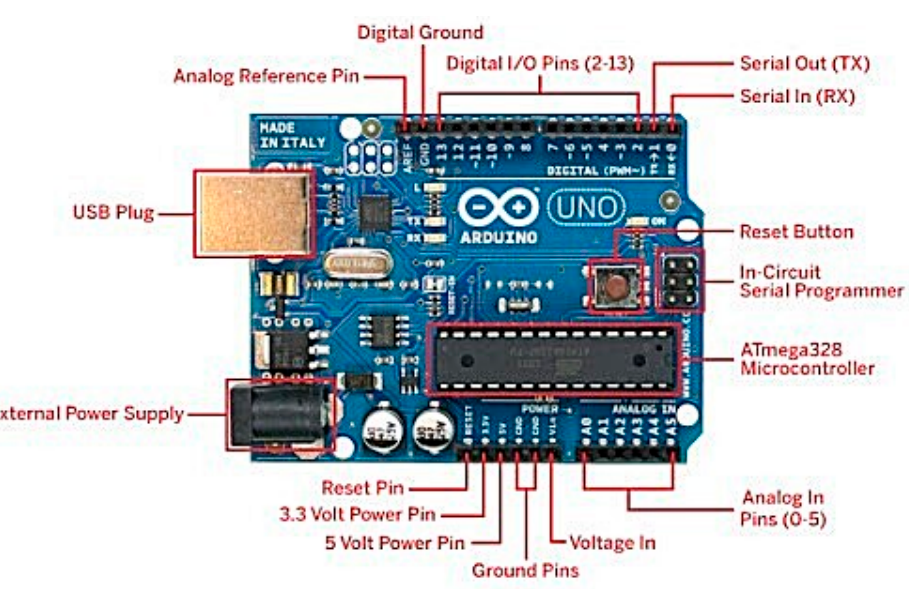
Figure 2. Arduino board and its connections.